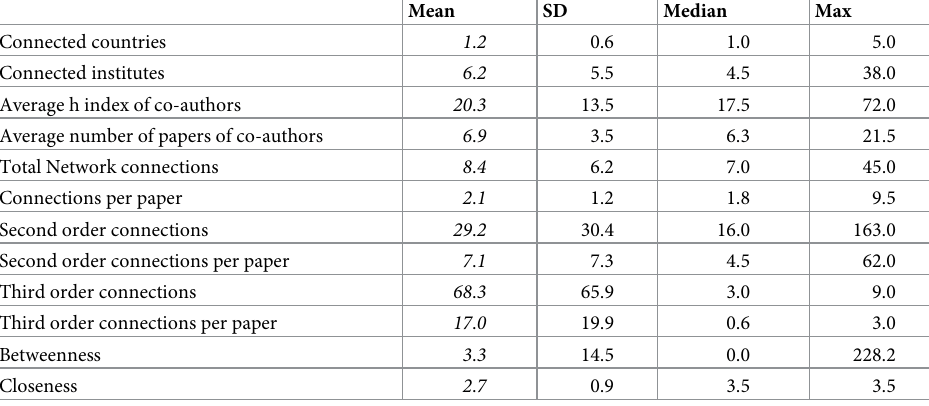
Table 2. Statistical data about authors in the co-authorship network.